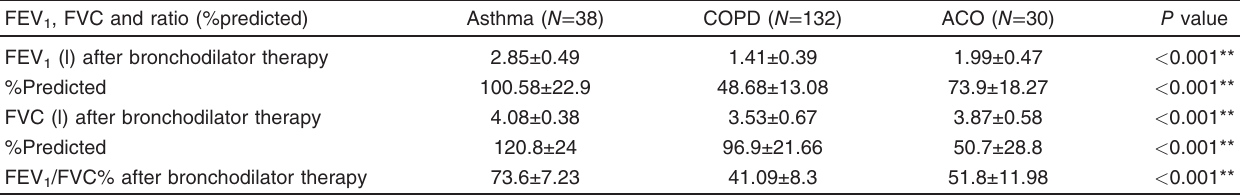
Table 3 Comparison of forced expiratory volume in 1s (%predicted), forced vital capacity (%predicted), and forced expiratory volume in 1s/forced vital capacity% after bronchodilator therapy among the studied groups FEV 1 , FVC and ratio (%predicted)